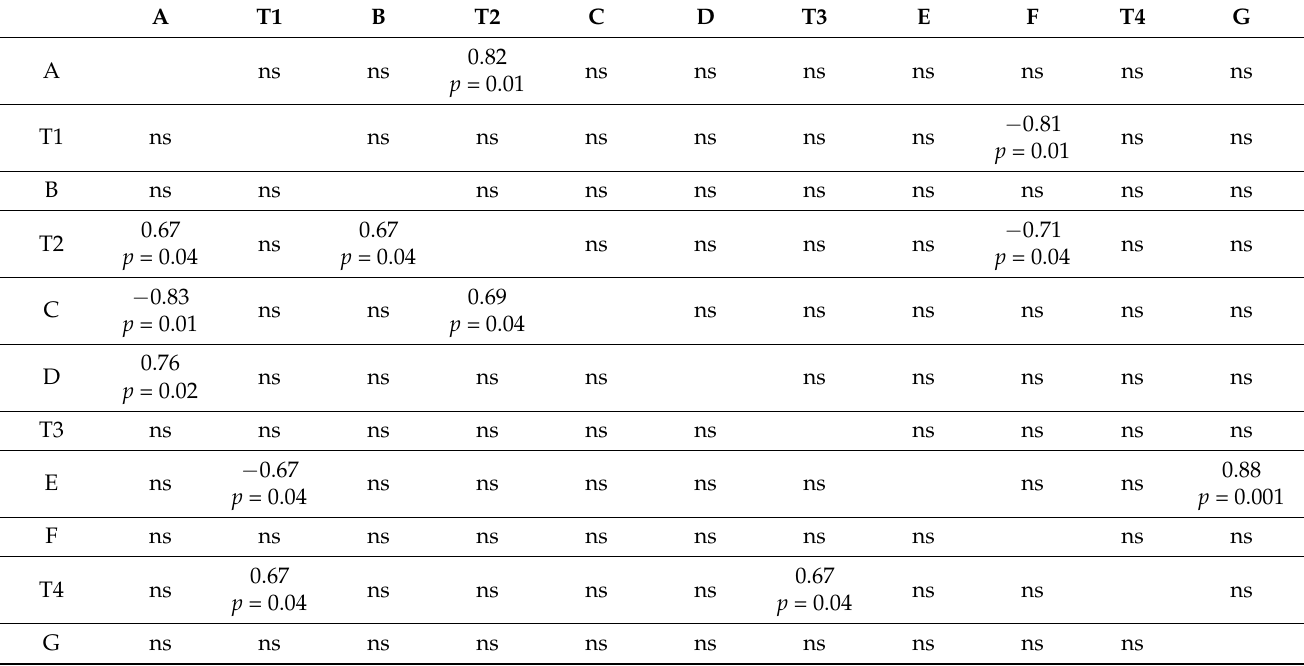
Table 2. Spearman R correlation coefficient and p value; above—up to 9-year-old mares; below—10-year-old and older mares.